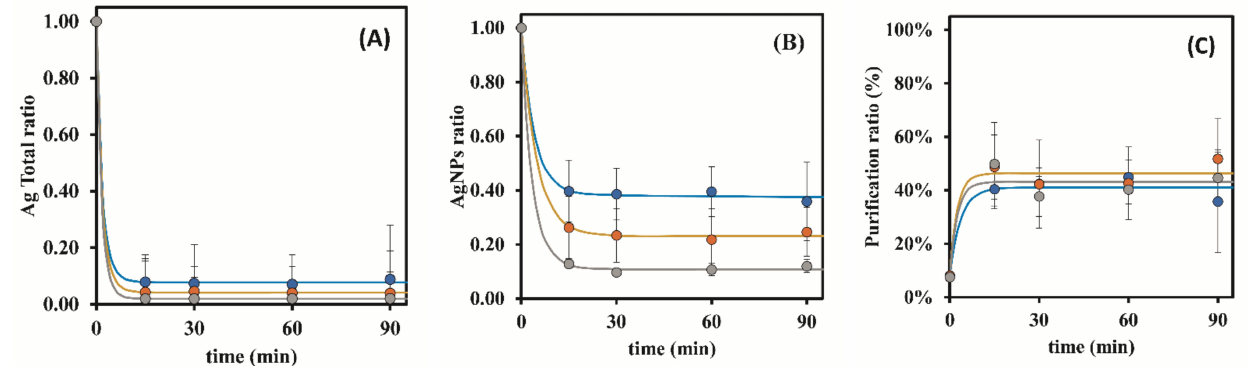
Figure 7. Influence of the resin mass (Bio-Rad 50W-X8 200–400 mesh) on the removal ratio of Ag + present in suspension over time ( • —0.25 g of resin; • —0.50 g of resin; • —1.00 g of resin): ( A )—Ag total ratio in the suspension; ( B )—AgNPs ratio in the suspension; ( C )—Purification ratio (%). The represented values are the average of 3 replicates for each different assay.